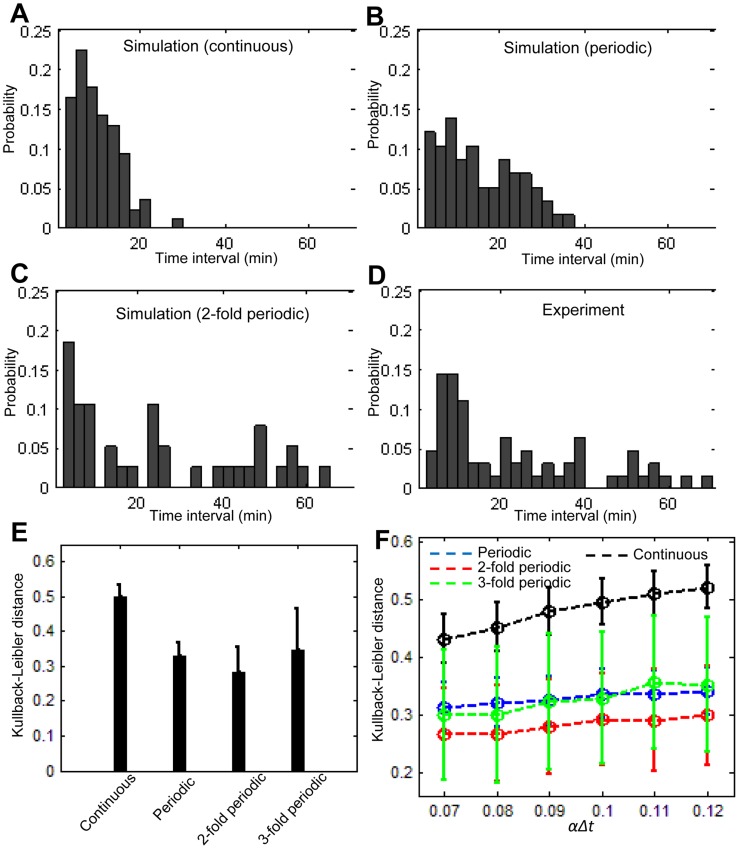
KL distance calculations with a probability distribution of the PGC time interval.(A–C) Probability distribution of the time interval for the PGC (posterior-most green cells) in the continuous model (z = 1), periodic model (z = 8) and two-fold periodic model (z = 16). (D) The distribution of the experiments was calculated by summing all three datasets for the time-lapse imaging. (E) KL distances for four different types of simulation: continuous (z = 1), periodic (z = 8), two-fold periodic (z = 16) and three-fold periodic (z = 24). For each model, the KL distance was calculated repeatedly 300 times, and the mean and standard deviation were then calculated. A significance test (Kolmogorov-Smirnov test) was applied for each combination of the KL distance datasets. All combinations exhibited statistical significance, with a p-values of <0.001. (F) The KL distance for six different probability values αΔt (αΔt = 0.07, 0.08, 0.09, 0.1, 0.11, 0.12). For each simulation (circle with error bar), the KL distance was calculated repeatedly 300 times, and the mean and standard deviation were determined.